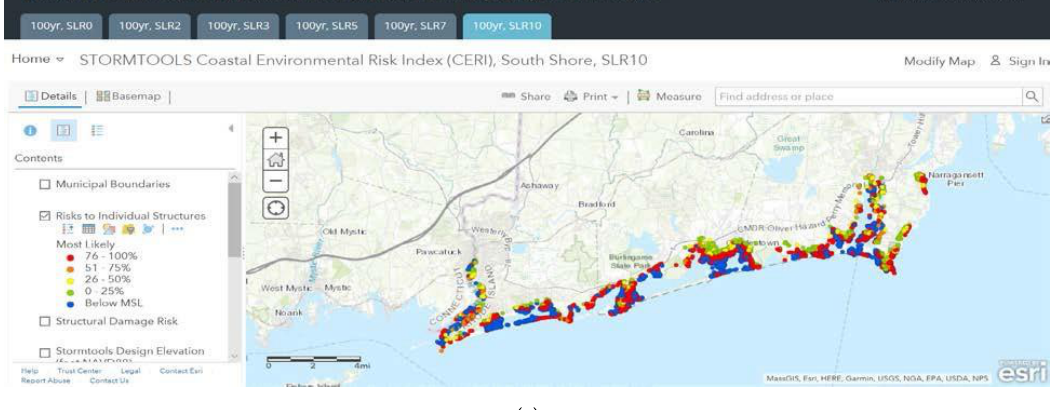
Figure 7. CERI predicted for 100 yr surge and varying SLR cases, ( a ) none (upper panel), ( b ) 5 ft (center panel), and ( c ) 10 ft (lower panel) for Southern Rhode Island (RI) shoreline. Legend shown on left. (CERI results are available for all SLR cases at: https: // crc-uri.maps.arcgis.com / apps / MapSeries / index.html?appid = 2a4ab310fecc4721935287e5a5f7ace4) accessed on 13 February